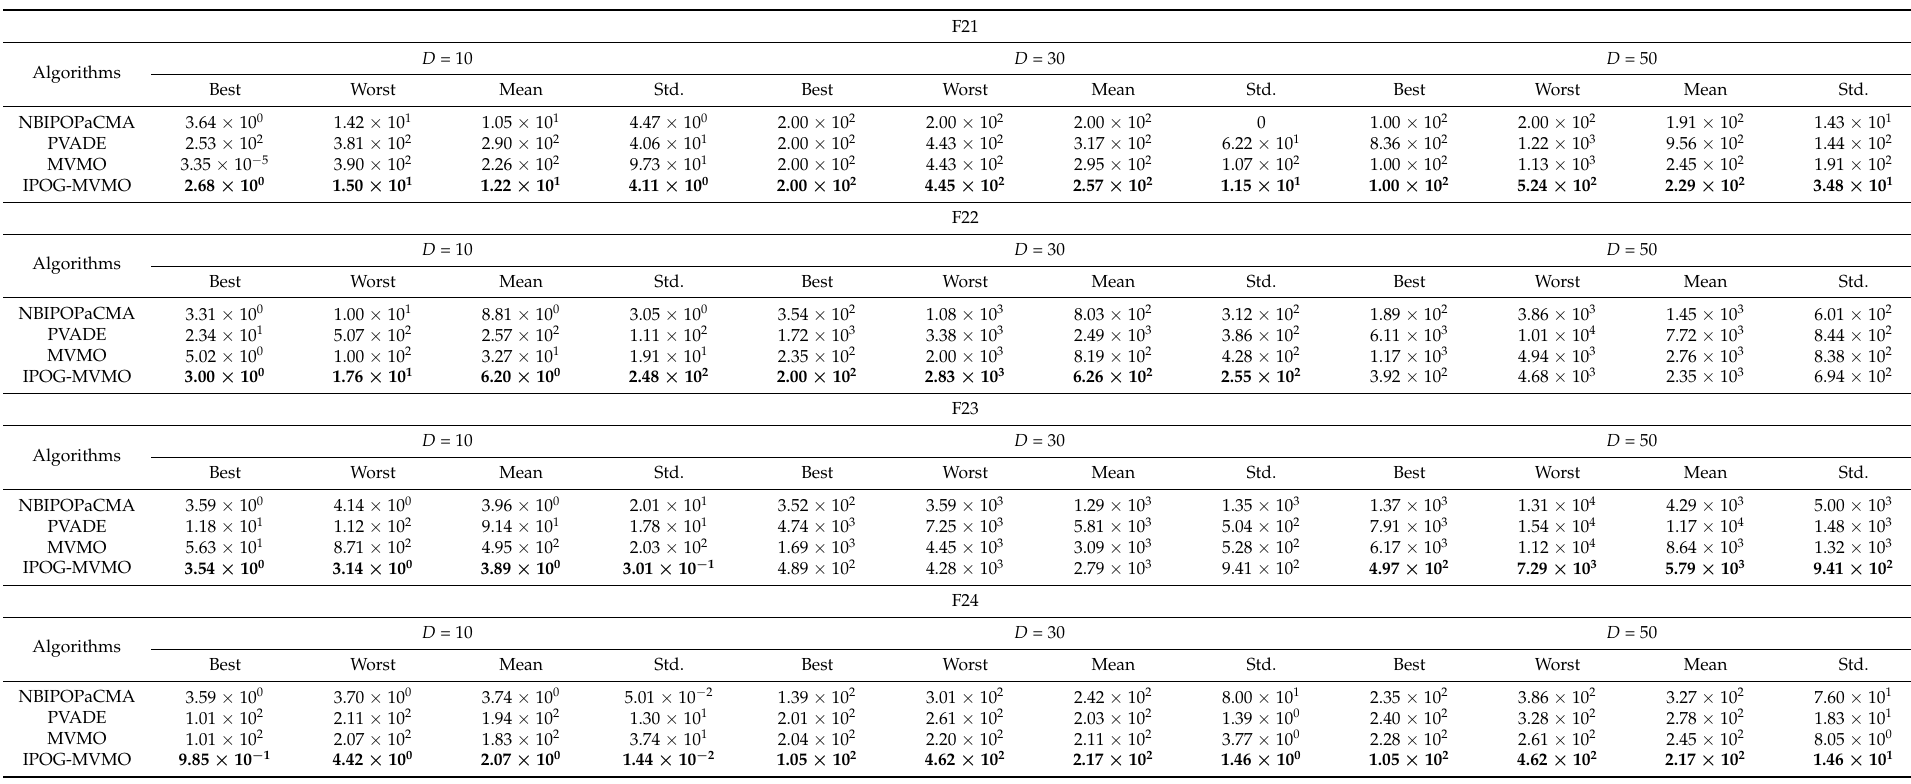
Table 7. The comparative results of the errors obtained from composition functions